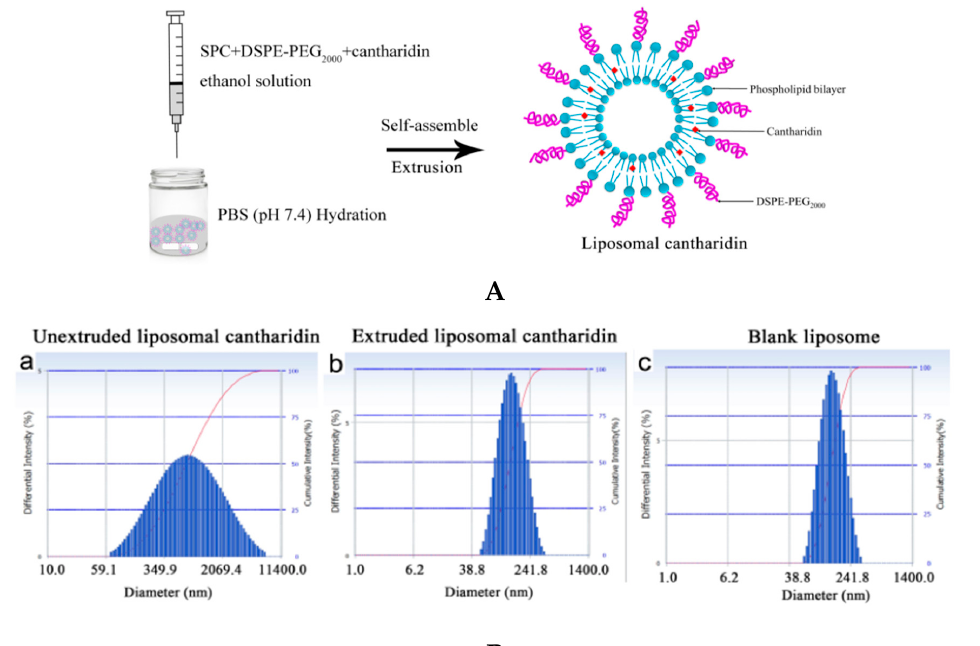
Figure 2. ( A ) Schematic illustration of cantharidin encapsulated into PEGylated liposome; and ( B ) size distribution of liposomes. Particle size of liposomal cantharidin before extrusion, after extrusion, and the blank liposome after extrusion was determined by a Delsa Nano equipment. Table 1. Properties of cantharidin-liposome and blank liposome ( n = 3, mean ± SD) Liposome Type Particle Size (nm) Liposomal